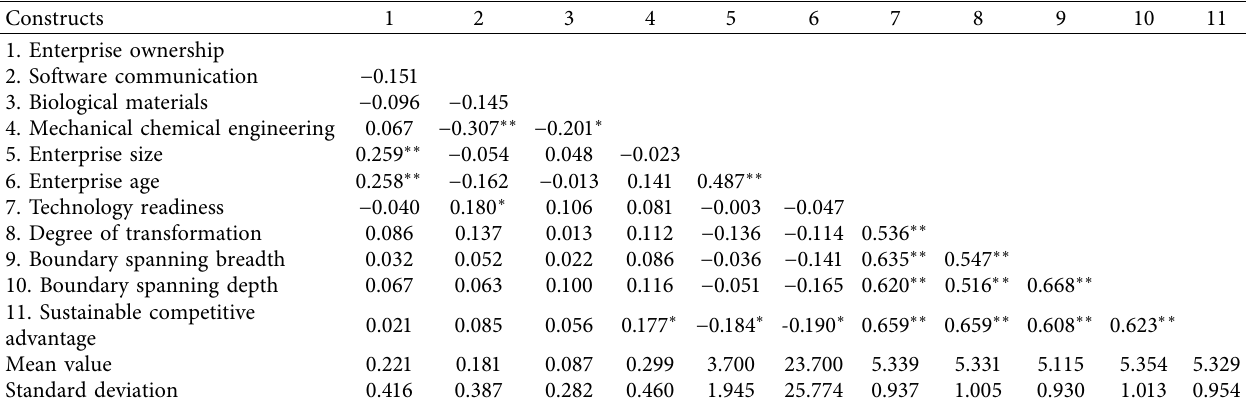
Table 4: Descriptive statistics and correlation coefficient